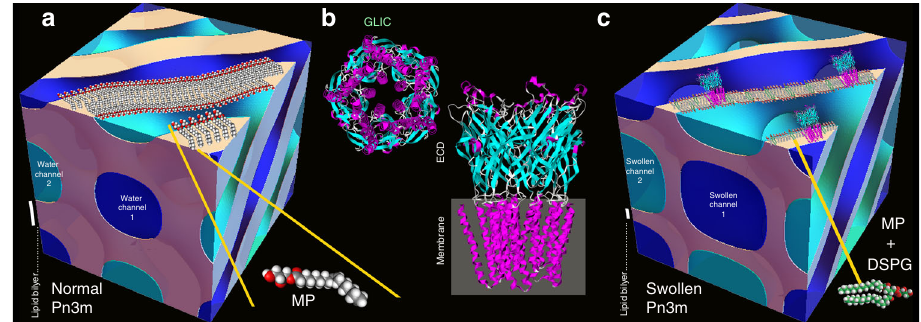
Fig. 1 Normal vs. swollen mesophases and the GLIC protein structure. Schematic illustrations of a normal Pn3m cubic mesophase composed of MP:water, b GLIC protein structure, and c in meso crystallization of GLIC protein in a highly swollen Pn3m cubic mesophase composed of DSPG:MP:water. Note the difference in size of the lipid bilayer scale bar, which is 30 Å, on a and